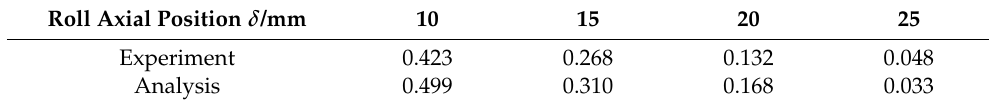
Table 6. Average specific twisted angle β ( ϕ = 20 ◦ , t = 2 mm). Unit: ◦ /mm.